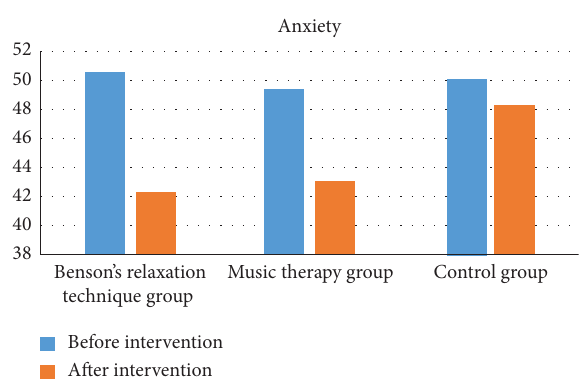
Figure 2: Comparison of anxiety between the study